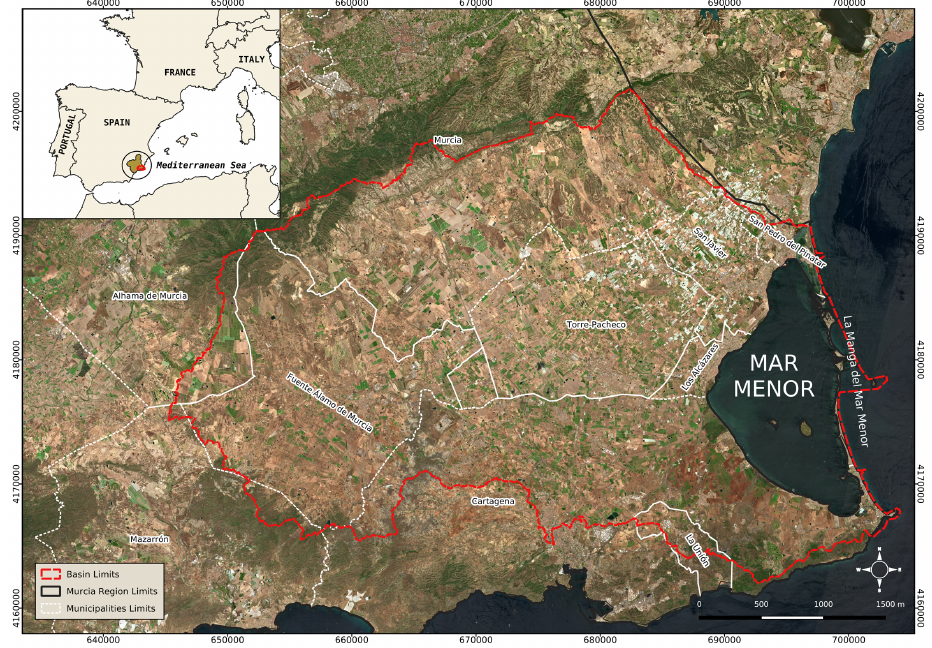
Figure 1. Study area: Mar Menor